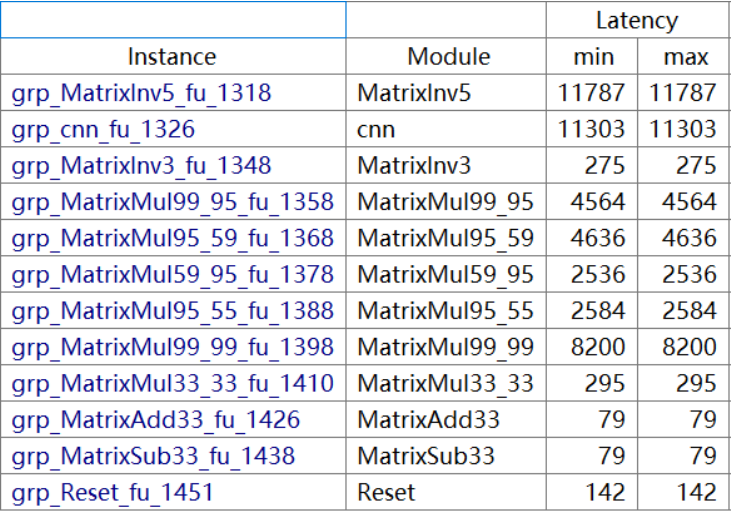
Figure 15. Latency of the modules from the HLS